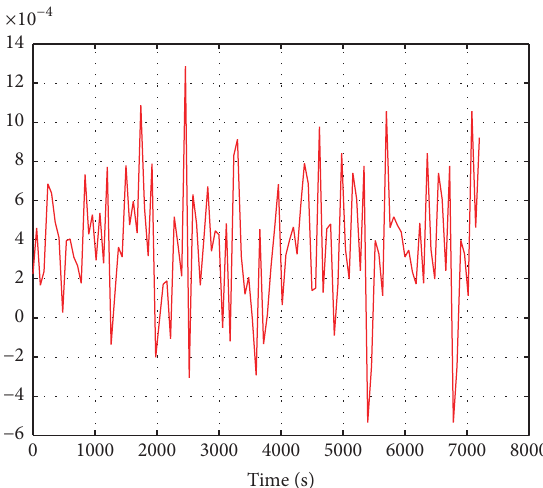
Figure 8: The variation of coverage rate difference when division granularity is 1 ∘ .